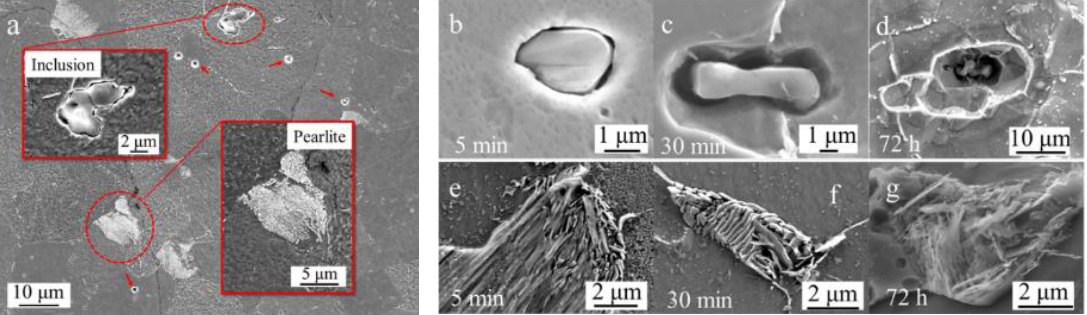
Figure 11. The morphology of samples after a series of immersion test: ( a , b , e ) 5 min; ( c , f ) 30 min; and ( d , g ) 72 h.